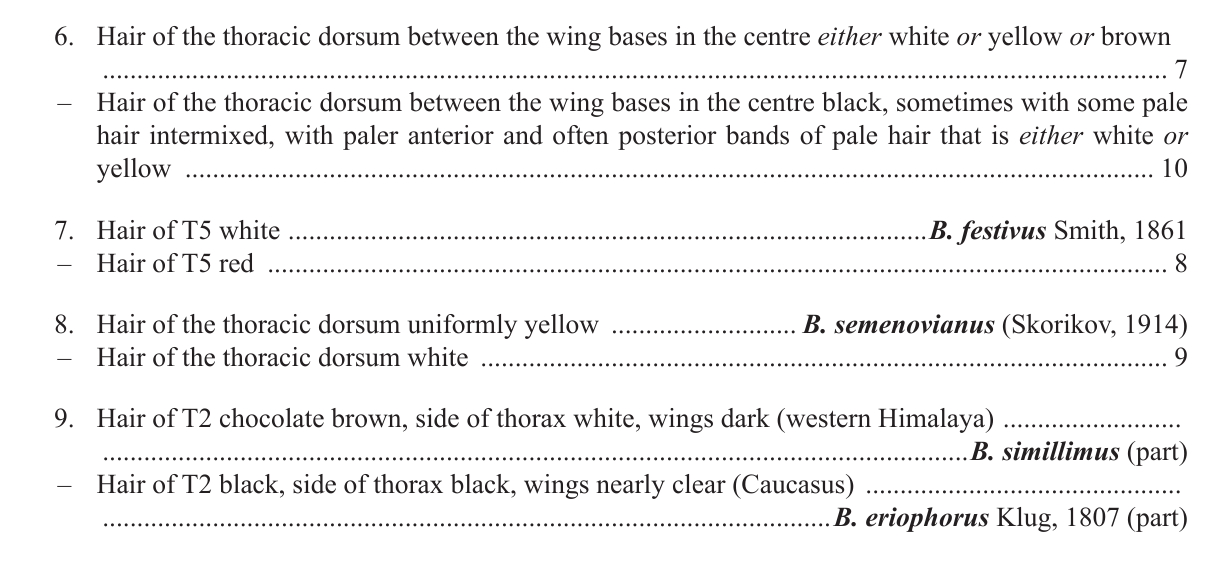
5. Hair of mid and hind tibiae black and T4‒5 red, hind tibia outer surface with many decumbent short – Hair of mid and hind tibiae orange or black, but if black then T4‒5 black, hind tibia outer surface without decumbent short branched black hairs (Sumatra, Java) ............. B. rufipes Lepeletier, 1835 6. Hair of the thoracic dorsum between the wing bases in the centre either white or yellow or brown – Hair of the thoracic dorsum between the wing bases in the centre black, sometimes with some pale hair intermixed, with paler anterior and often posterior bands of pale hair that is either white or